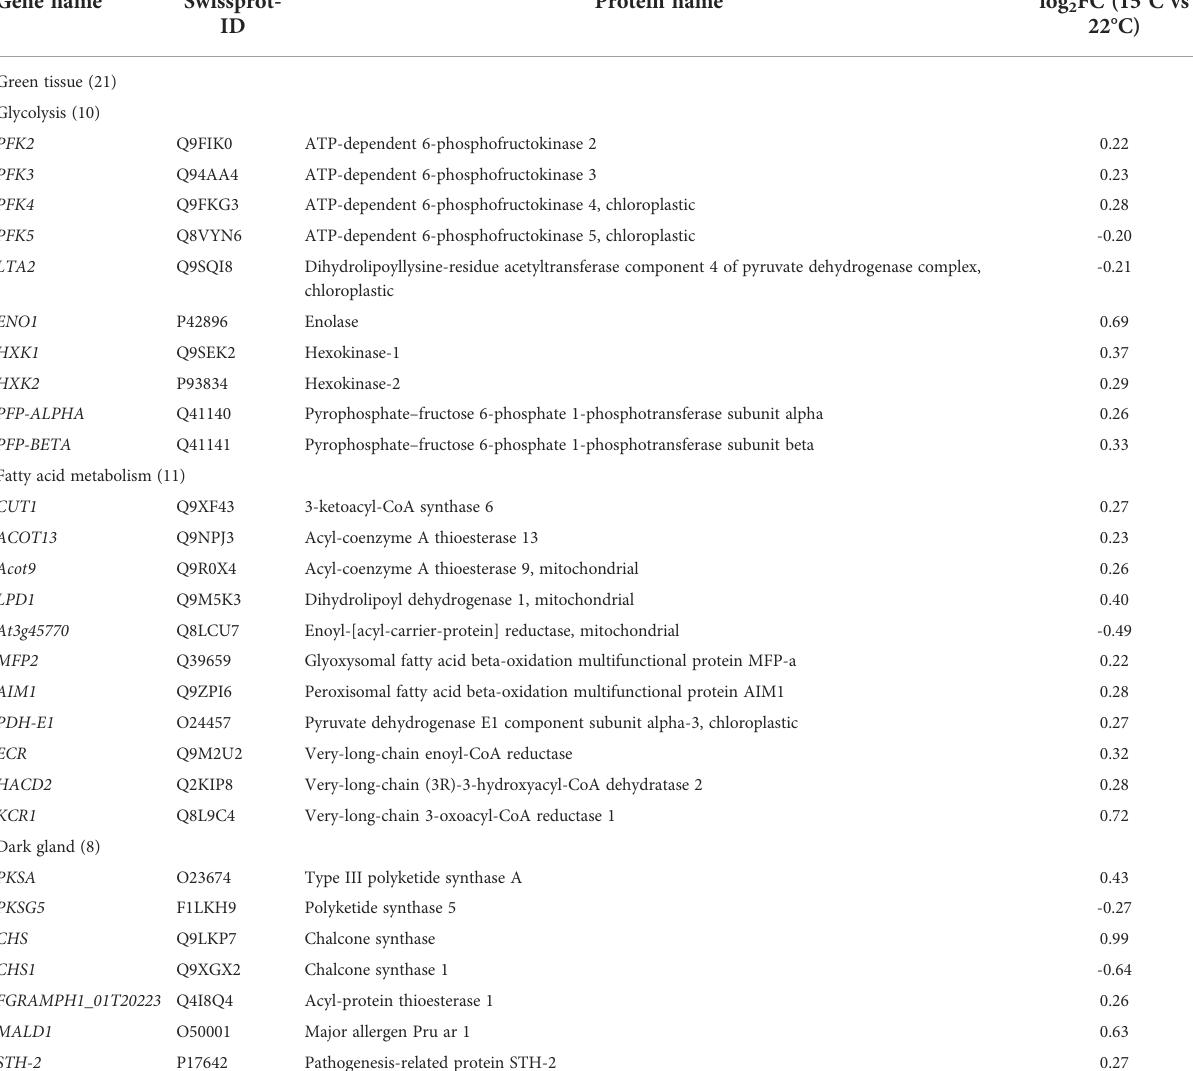
TABLE 1 Twenty nine genes involved in Hyp biosynthesis in green tissue and dark